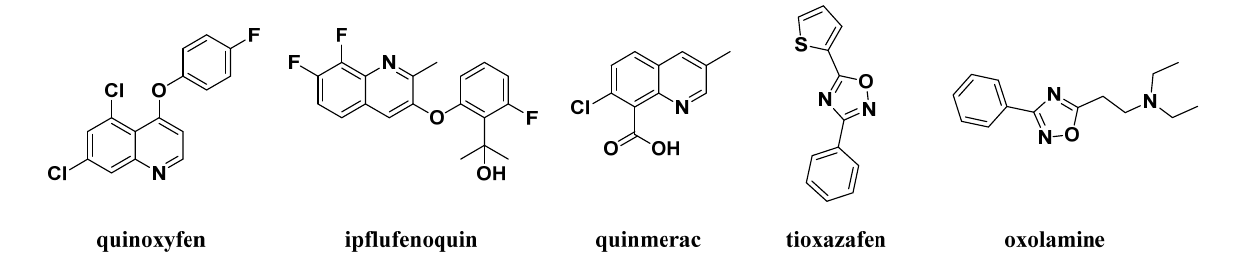
Figure 1. Chemical structures of quinoxyfen, ipflufenoquin, quinmerac, tioxazafen and oxolamine.